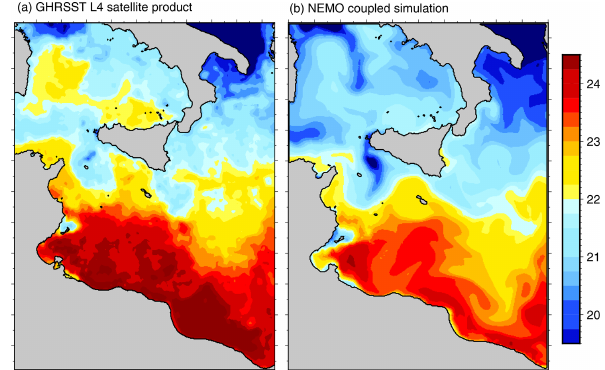
Figure 2. Map of the SST ( ◦ C) in the GHRSST L4 satellite product at 00:00UTC (a) and in the output of the Nucleus for European Modelling of the Ocean (NEMO) simulation at 01:00UTC (b) on 7 November.